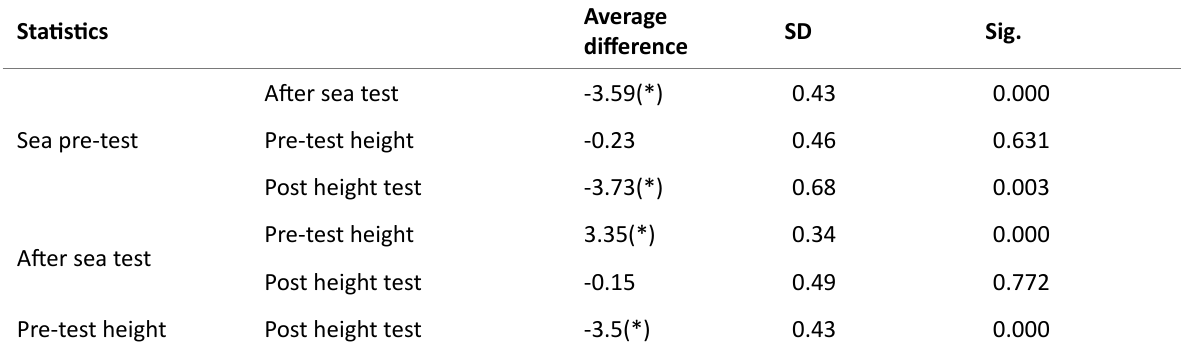
Figure 1. Average changes of testosterone in different stages of puddle Table 3. Testing for repeated measurements of lymphocytes at different stages Statistics